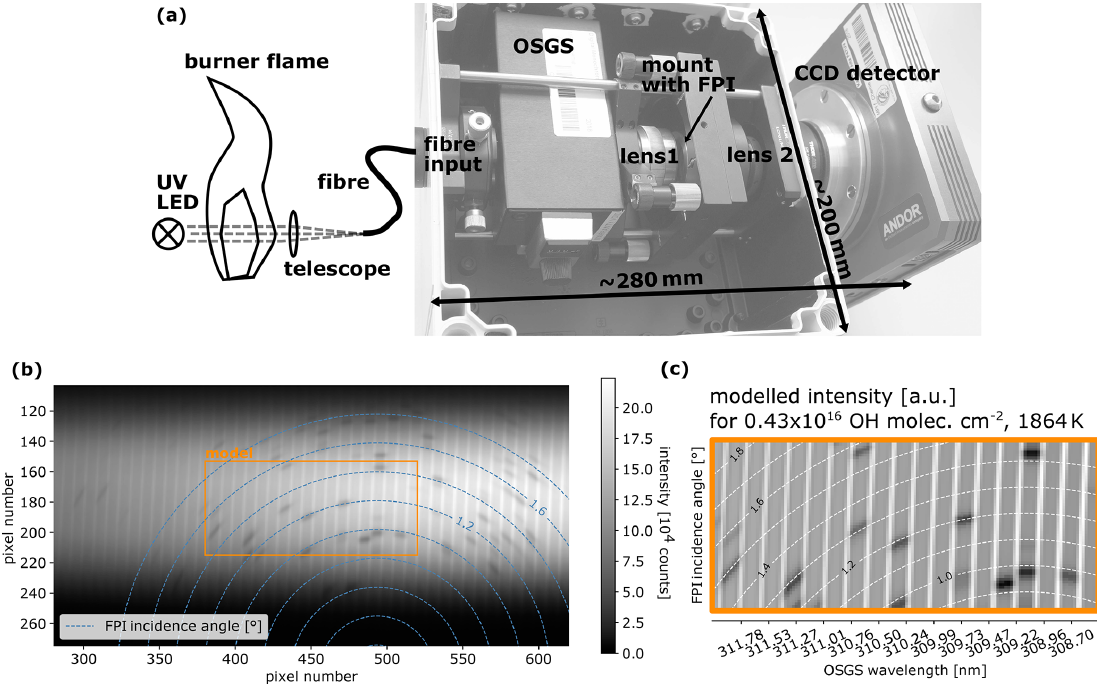
Figure 5. Prototype of an FPI spectrograph with a grating OSM recording an absorption spectrum of OH in a burner flame. Panel (a) outlines the instrument and experimental set-up: light from a UV LED traverses a burner flame (containing a high amount of hot OH) before being directed to the FPI spectrograph via a telescope and a fibre. The FPI imaging optics re-image the moderate-resolution spectrum of the OSGS (compare Fig. 2). Panel (b) shows the recorded spectrum image: the vertical bright stripes arise from slight overlapping of FPI orders, dark spots indicate the individual OH absorption lines, and the dashed blue lines indicate rings of equal FPI incidence angle α . (c) Modelled intensities (using high-temperature OH absorption data from Rothman et al., 2013) for a part of the measured spectrum (orange box) with an instrument model show excellent